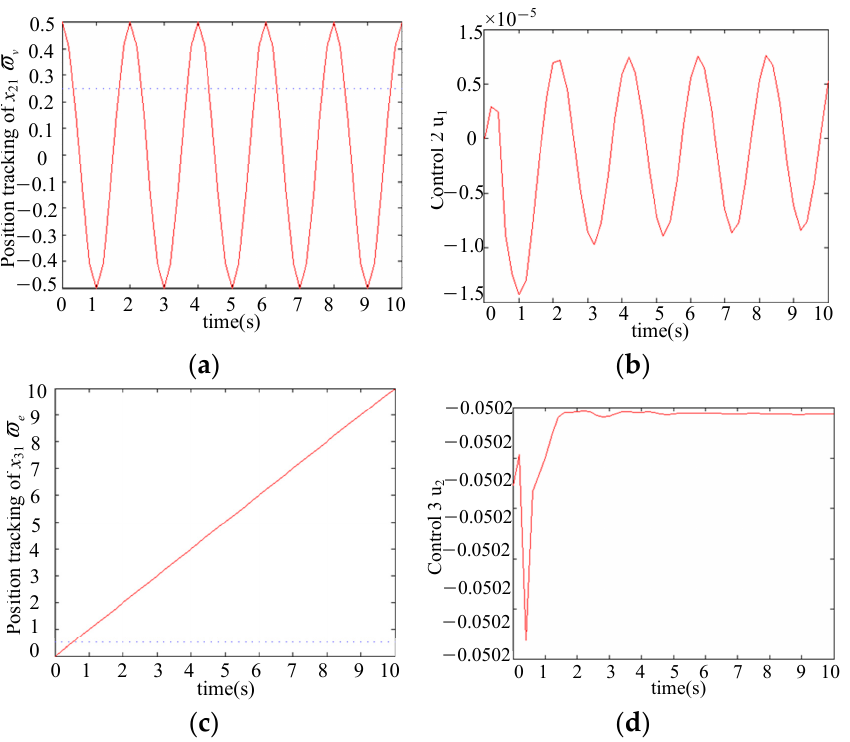
Figure 5. Output of the system state control function simulation. ( a ) Drive wheel angular speed. ( b ) ϖ v controller output curve. ( c ) Motor angular speed. ( d ) ϖ e controller output curve. After stabilization, the simulation result of the control output u 1 for the drive wheel angular velocity x 2 is floating, but the range of the floating value is − 1.5 × 10 − 5 to 0.75 × 10 − 5 , and the simulation result of the control input u 2 for the motor angular velocity x 3 is also floating. However, the floating value is always approximately − 0.0502. Thus, convergence and chattering are considered to have been eliminated.